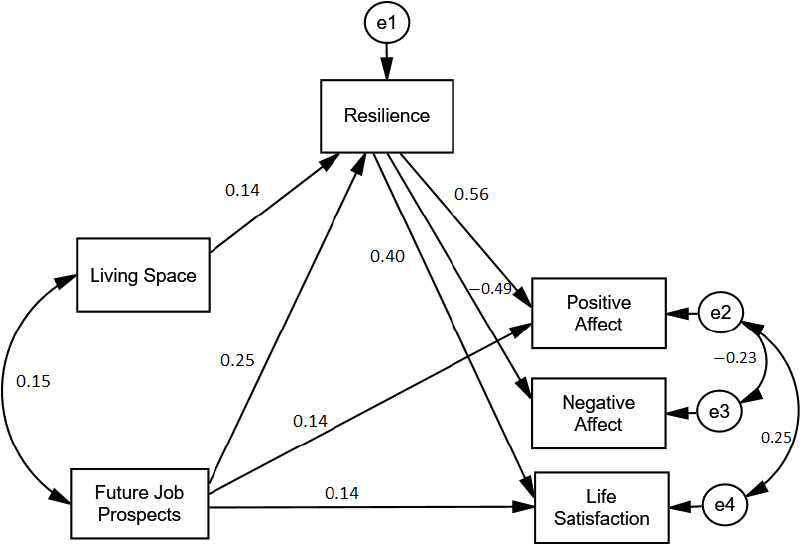
Figure 2. Standardised path coefficients among the variables. All the path coefficients are statistically significant.